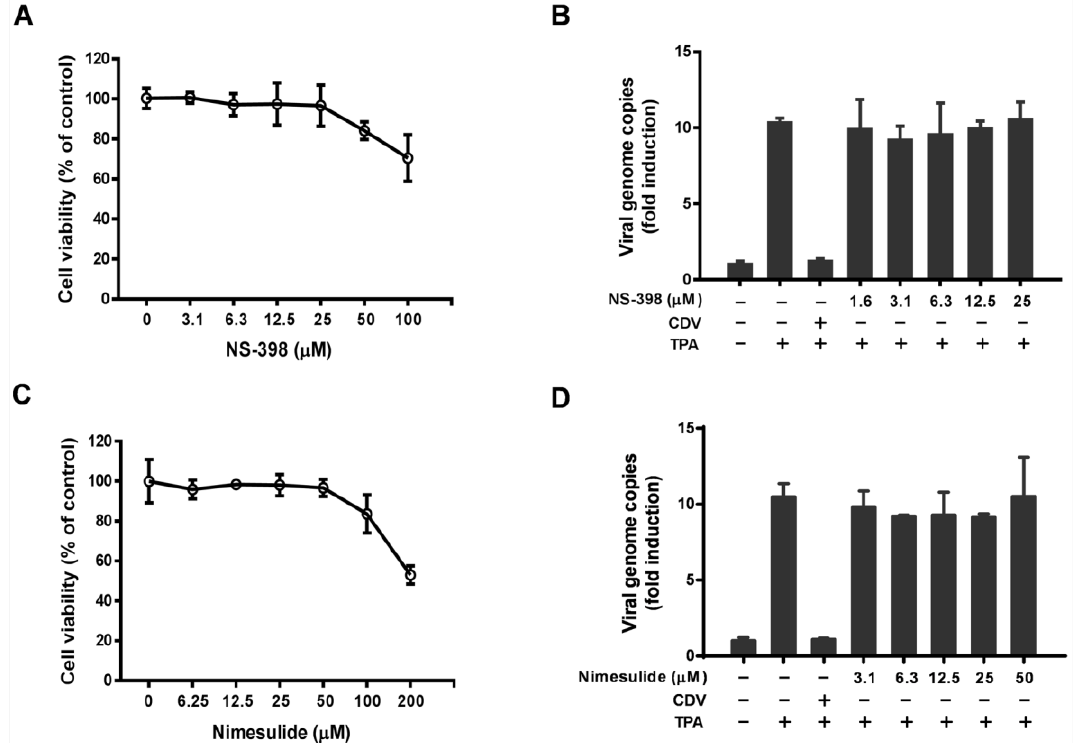
Figure 2. COX-2 inhibitors, NS-398 and nimesulide, have no effect on KSHV lytic replication in BCBL-1 cells. The cells induced with TPA for 3 h were treated with the test compounds for 72 h. Then, the effect of NS-398 and nimesulide on cell viability ( A , C ) and the number of DNA copies ( B , D ) were measured as described in the Methods. CDV (20 µM) is a positive control for inhibiting viral DNA replication. Data were normalized as the fold change compared with the no-TPA induced control. The results are presented as the mean values with standard deviations ( n =